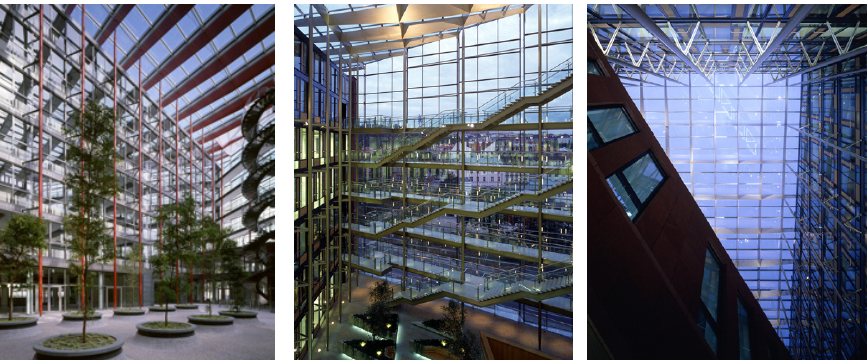
Figure 3: Nile House. - Figure 3 and 4: Danube